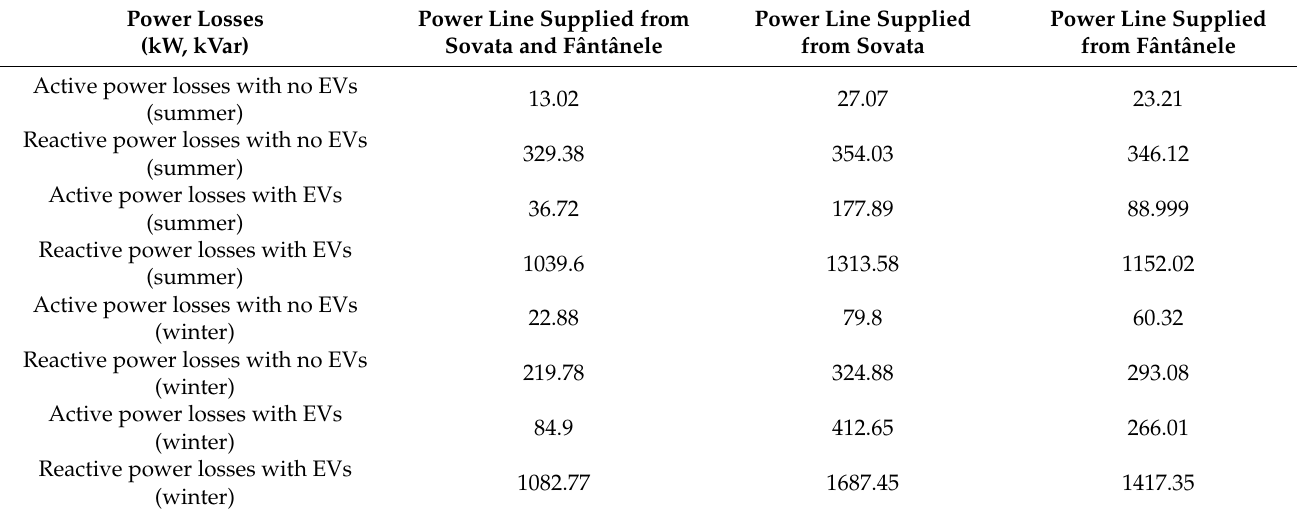
Table 20. Power losses at 12:00 (scenario 4).